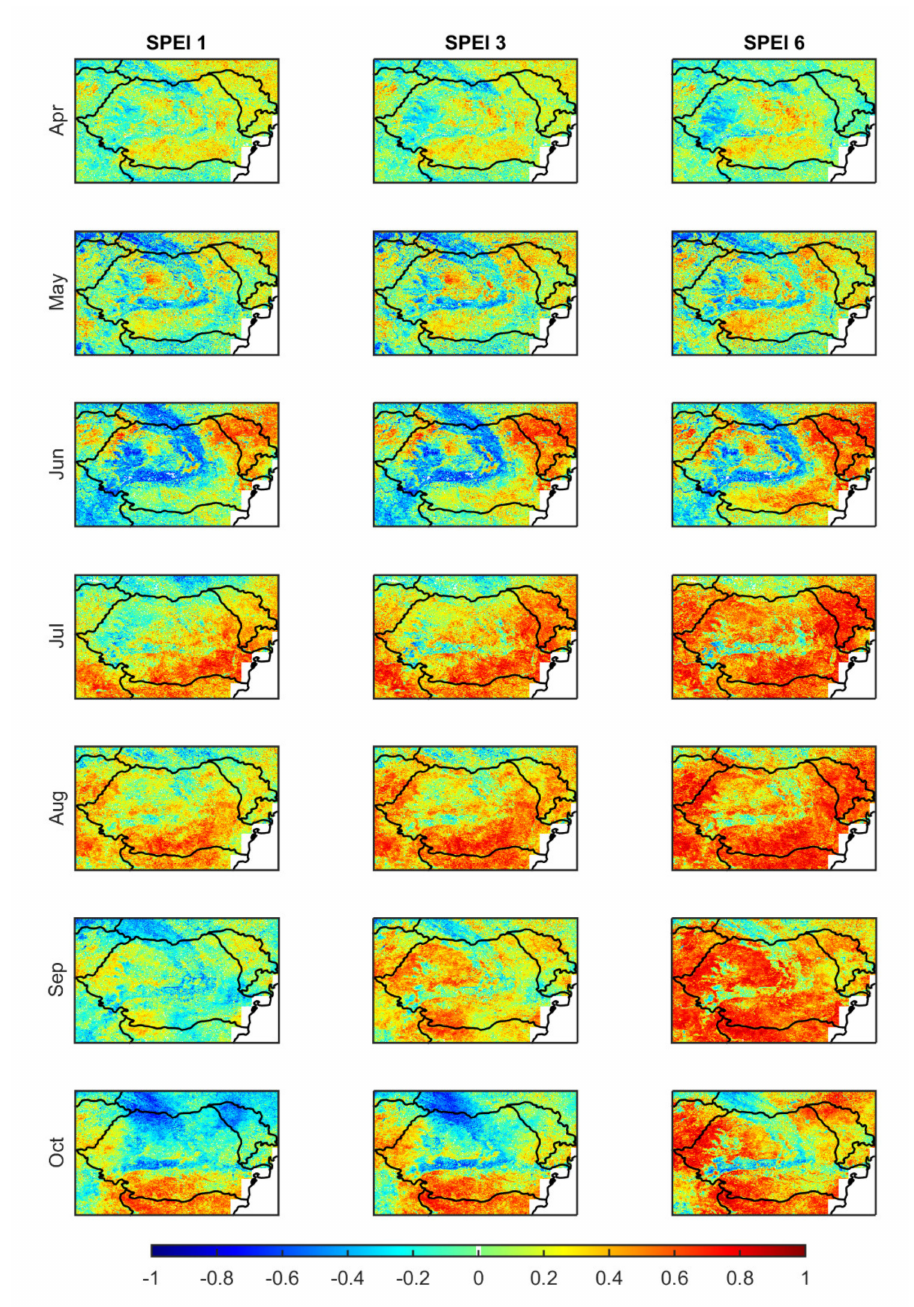
Figure 2. Correlation between detrended NDVI and SPEI from April to October, for the time scales of 1, 3 and 6 months. The minimum significant correlation is ±